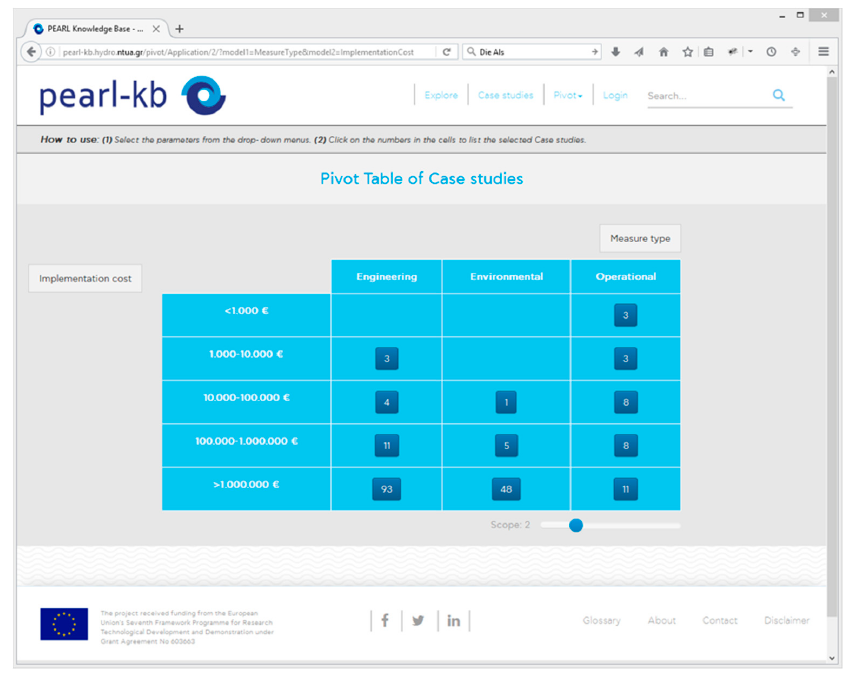
Figure 7. Example of a pivot table showing the number of case studies that meet certain